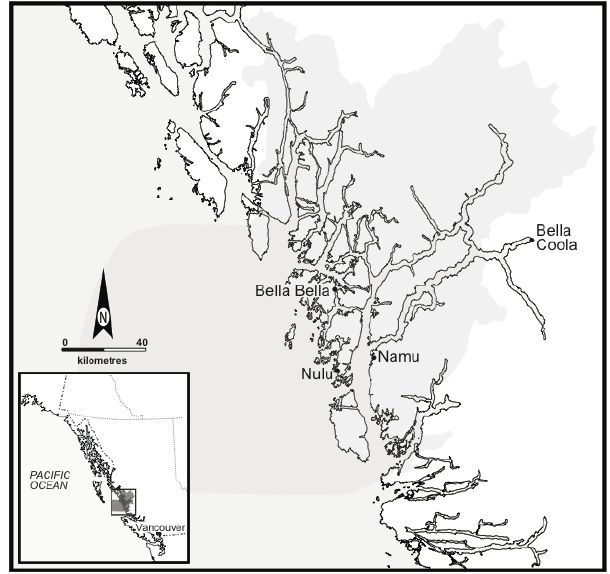
Fig. 1 . Location of Bella Bella, and the ancient settlement sites, Nulu and Namu, on the central coast of British Columbia, Canada. Map prepared by Shannon